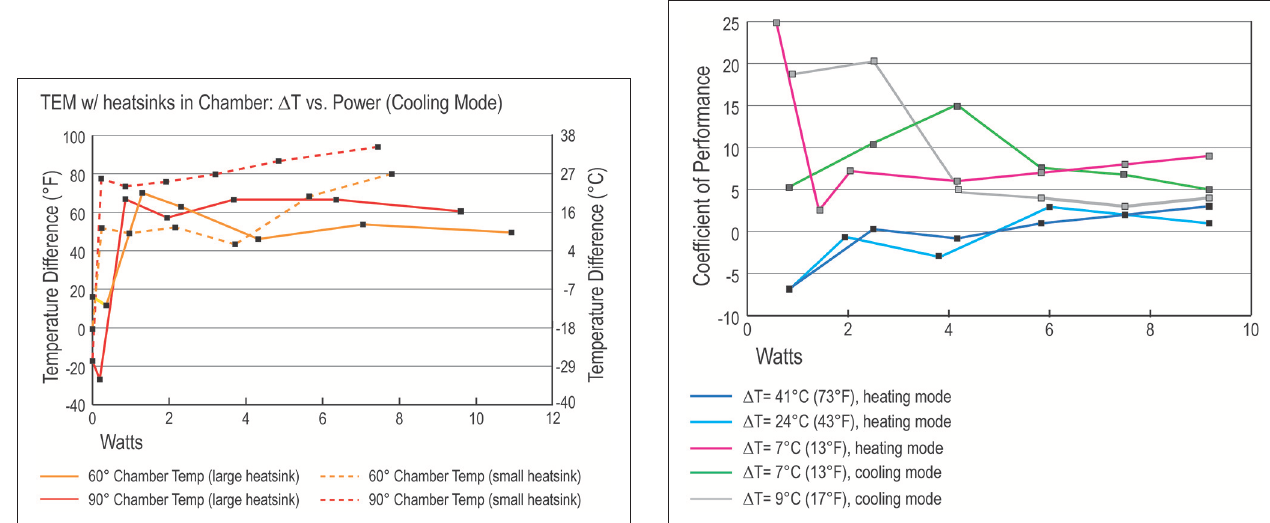
FIGURE 11 | 1 T vs. Watts in cooling mode. FIGURE 12 | Coefficient of performance.